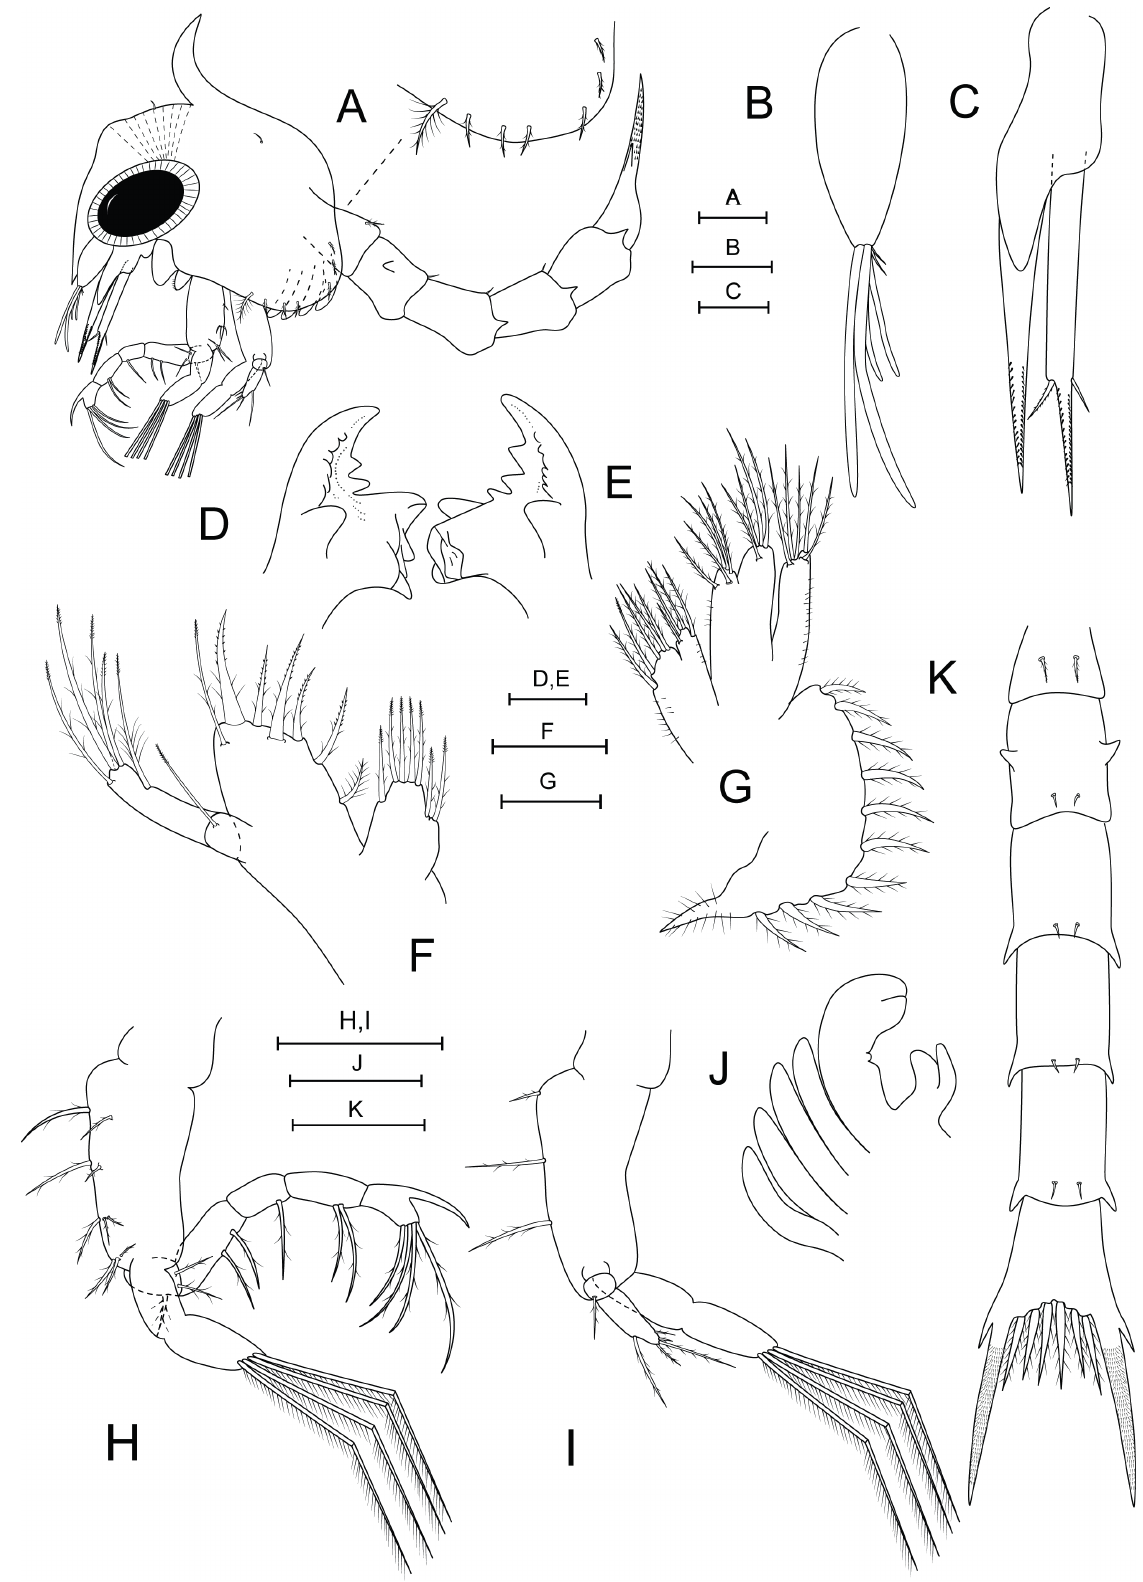
Figure 1. Macrocoeloma subparallelum (Stimpson, 1860) first zoeal stage. (A) Lateral view; (B) antennule; (C) antenna; (D) mandible, right side; (E) mandible, left side; (F) maxillule; (G) maxilla; (H) maxilliped I; (I) maxilliped II; (J) maxilliped III and pereopods; (K) pleon. Scale bars: A, 0.3 mm; B–G, 0.1